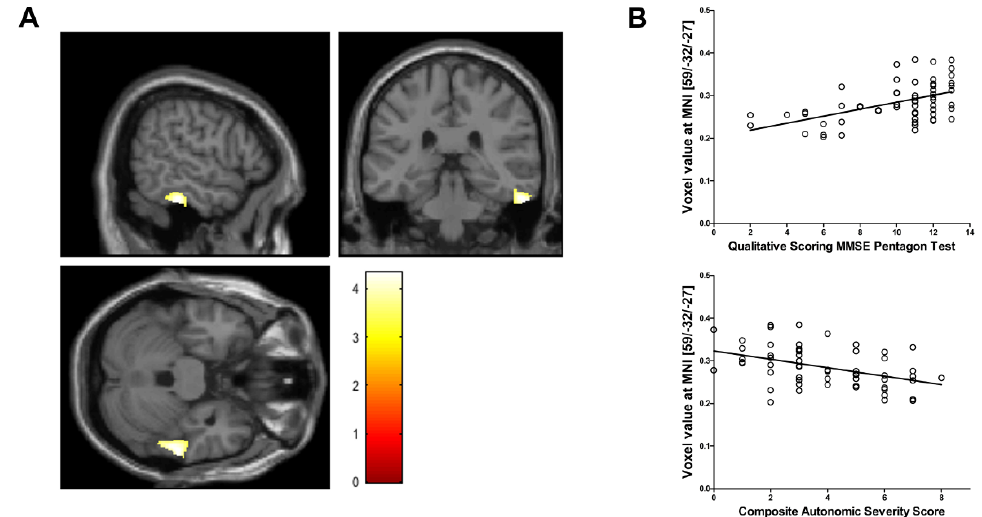
Figure 1. ( A ) Voxel-based morphometry shows a significant regional gray matter volume reduction in the right inferior temporal cortex in Parkinson’s disease patients with orthostatic hypotension (OH) compared with those without OH (voxel-level uncorrected p < 0.001, familywise error-corrected p < 0.001 after small volume correction). The color bar represents the T value. ( B ) The normalized volume of the right inferior temporal cortex (raw volume/estimated total intracranial volume [eTIV] × 100) has a positive relationship with Qualitative Scoring MMSE Pentagon Test (QSPT) and a negative relationship with Composite Autonomic Severity Score